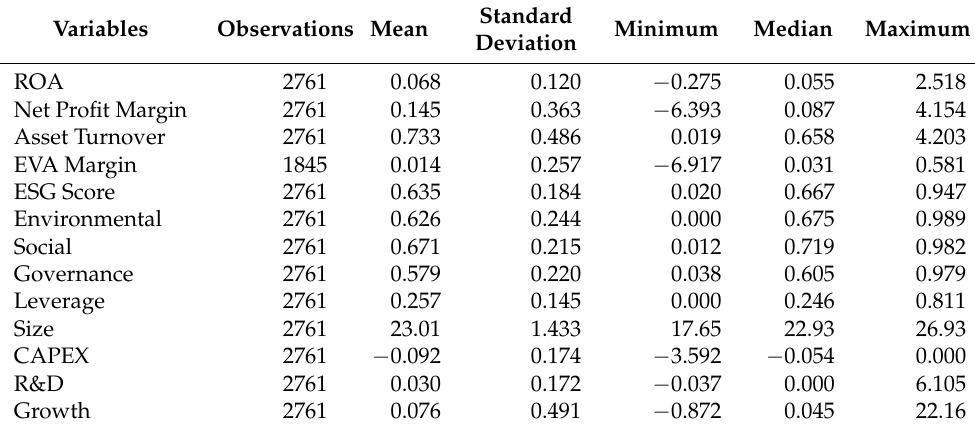
Table 2. Descriptive